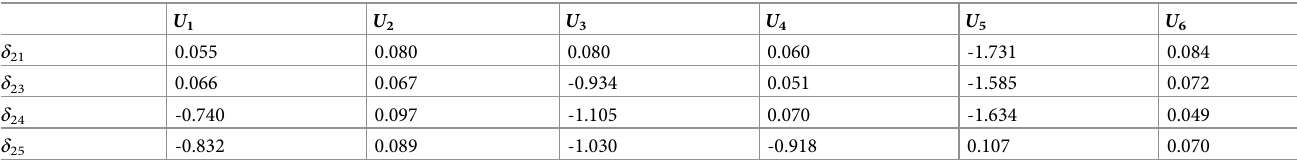
Table 25. The dominance of O 2 to others.